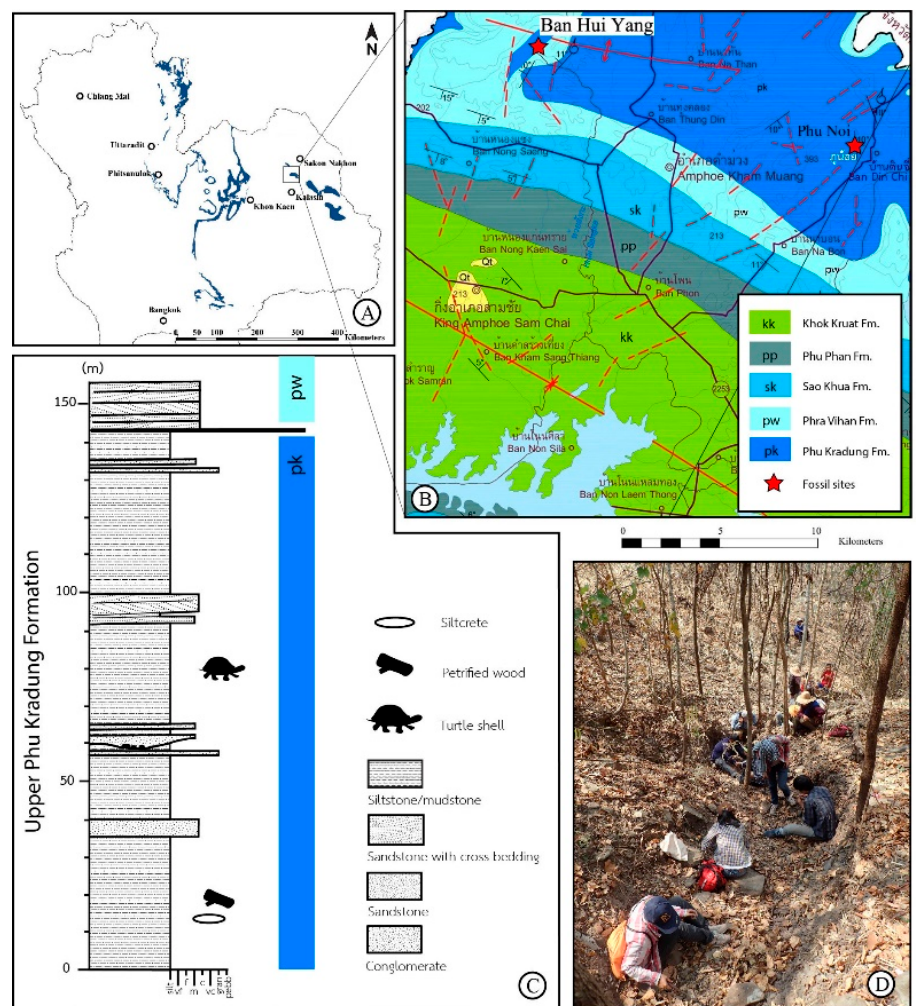
Figure 1. ( A ), Map of northern Thailand showing location of Sam Chai area, and outcrops of the Phu Kradung Formation; ( B ): Geological map of Sam Chai area (modified from [20]; ( C ): Stratigraphical column of Ban Hui Yang site; ( D ): Field work.